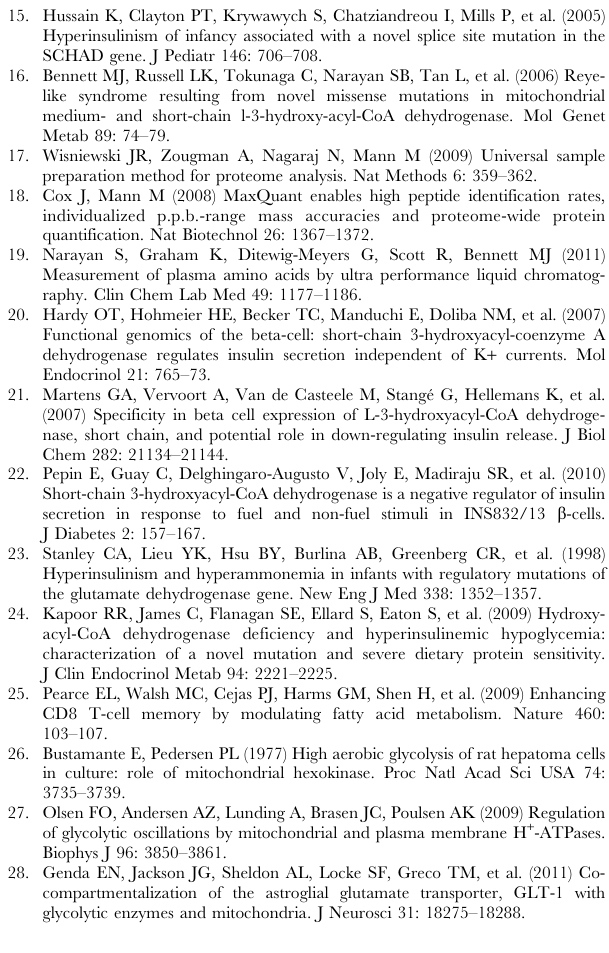
Table S1 Full pulldown proteomic details from wild type and SCHAD knockout brain. Table S2 Full pulldown proteomic details from wild type and SCHAD knockout kidney.